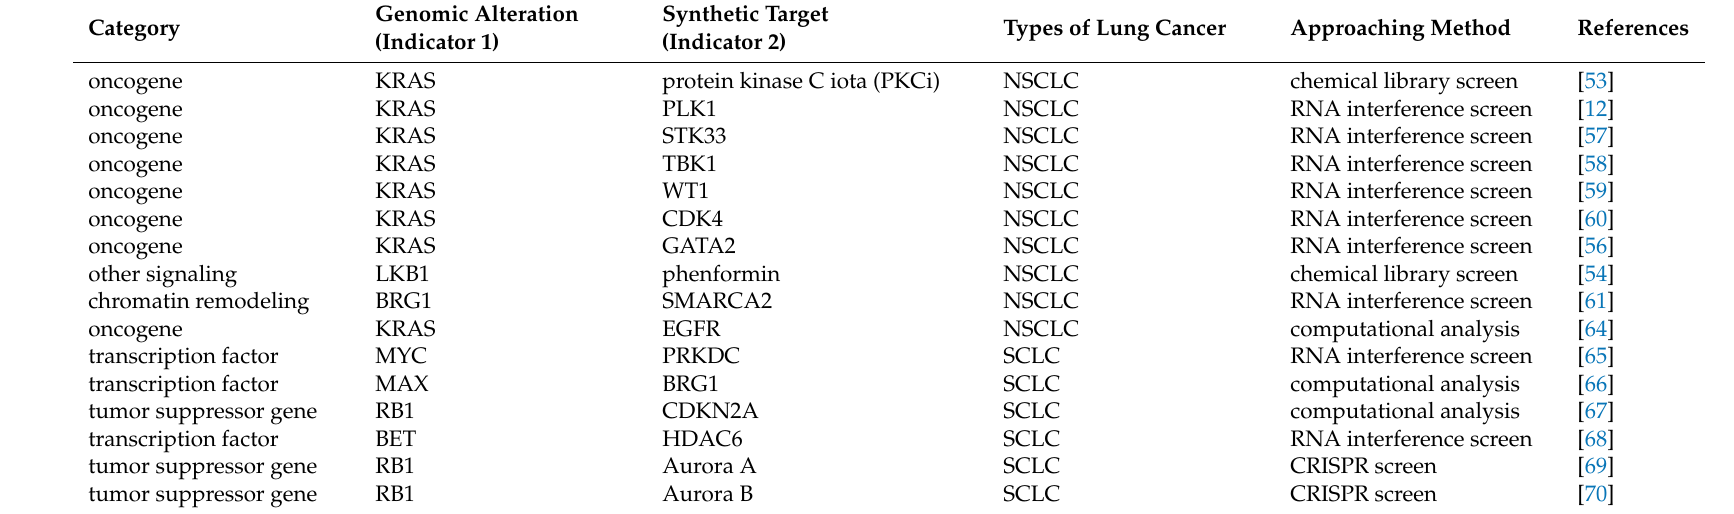
Table 1. Synthetic lethal combination and approaching method in lung